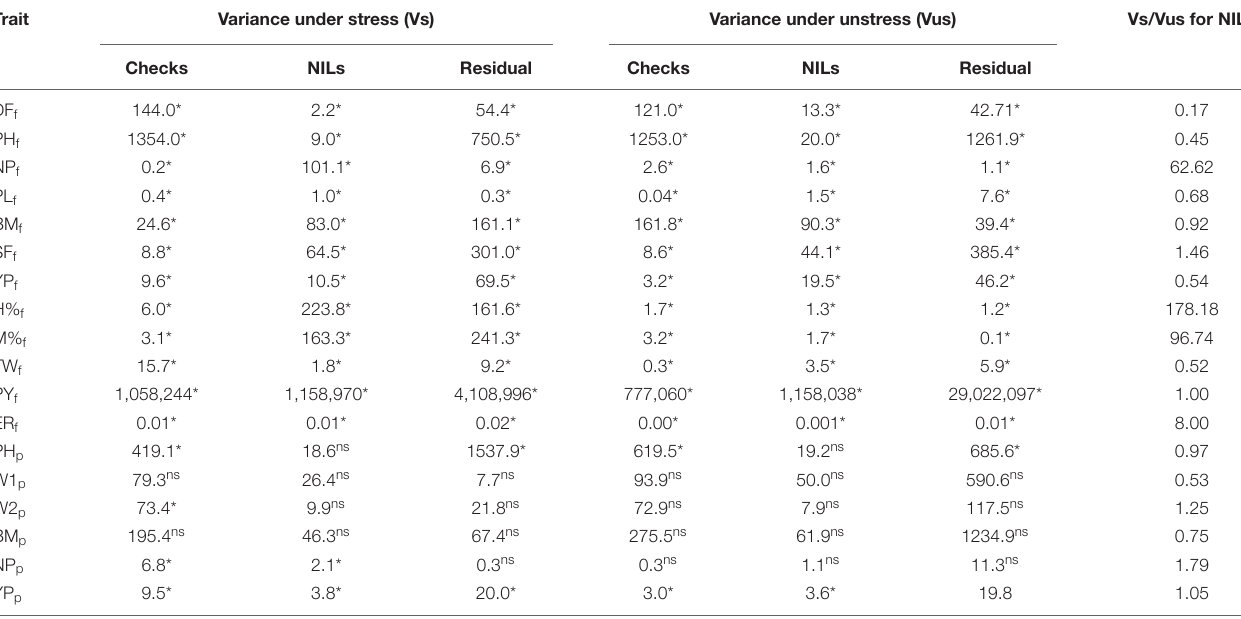
TABLE 2 | The ANOVA for agronomic traits showing components of variance under stressed and unstressed treatments in the near-isogenic lines (NILs) in the field trial.